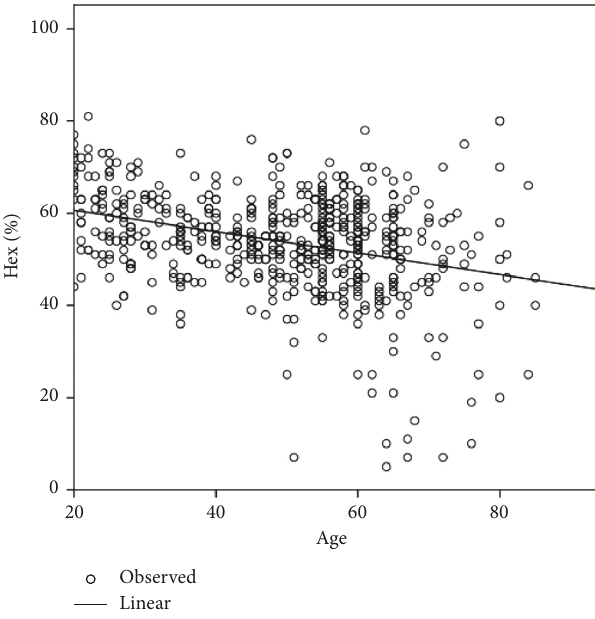
Figure 4: Relationship between the percentage of hexagonal cells (Hex (%)) and age in Egyptian subjects with healthy